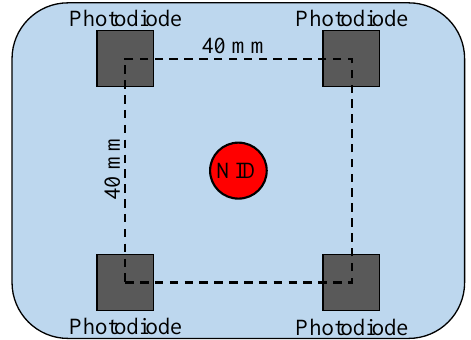
Figure 2. The distribution diagram of the probes.